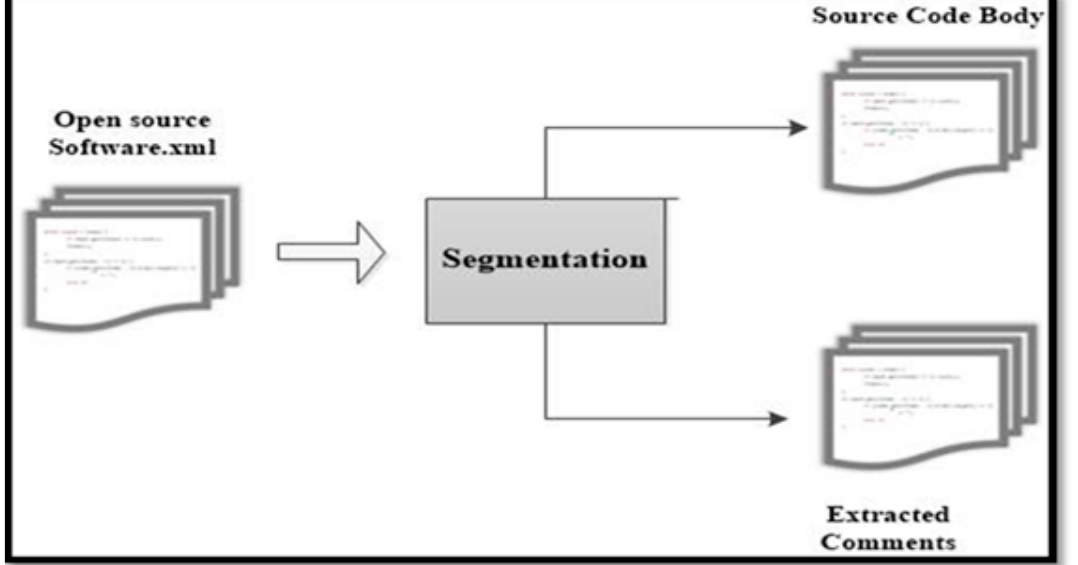
Figure 5. The segmentation phase.